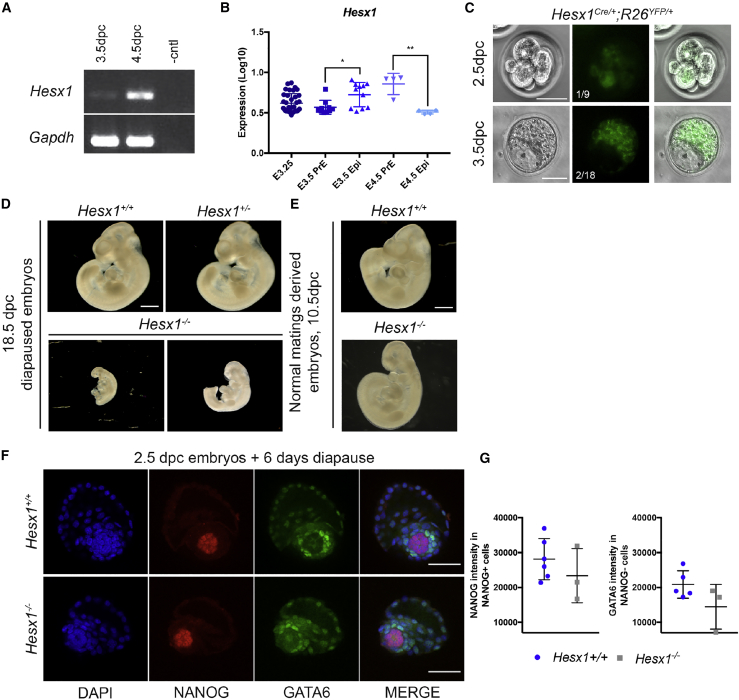
Lack of Hesx1 Expression in Embryos Disrupts Developmental Diapause(A) Hesx1 expression in 3.5- and 4.5-dpc C57BL/6J WT blastocysts.(B) Hesx1 expression at different time points of preimplantation development measured by single-cell microarray. Hesx1 is expressed at higher levels in the Epi lineage at 3.5 dpc (n = 10, ∗p < 0.01), but its expression becomes associated with PrE at 4.5 dpc (n = 4, ∗∗p < 0.005).(C) Bright-field and immunofluorescence images of 2.5- and 3.5-dpc Hesx1Cre/+;R26YFP/+ embryos. Only 1 of 9 and 2 of 18 embryos showed YFP expression. Scale bars, 50 μm.(D) 18.5-dpc diapaused embryos (8 days in diapause, then transferred to recipient females for further 10 days). Scale bar, 1 mm.(E) 10.5-dpc Hesx1+/+ and Hesx1−/− embryos derived from conventional matings. Scale bar, 1 mm.(F) Immunofluorescence against NANOG and GATA6 in embryos after 6 days of diapause. Scale bar, 50 μm.(G) Scatterplot of NANOG and GATA6 mean fluorescence intensity in Hesx1+/+ (n = 6) and Hesx1−/− (n = 3) embryos subjected to 6 days of diapause.